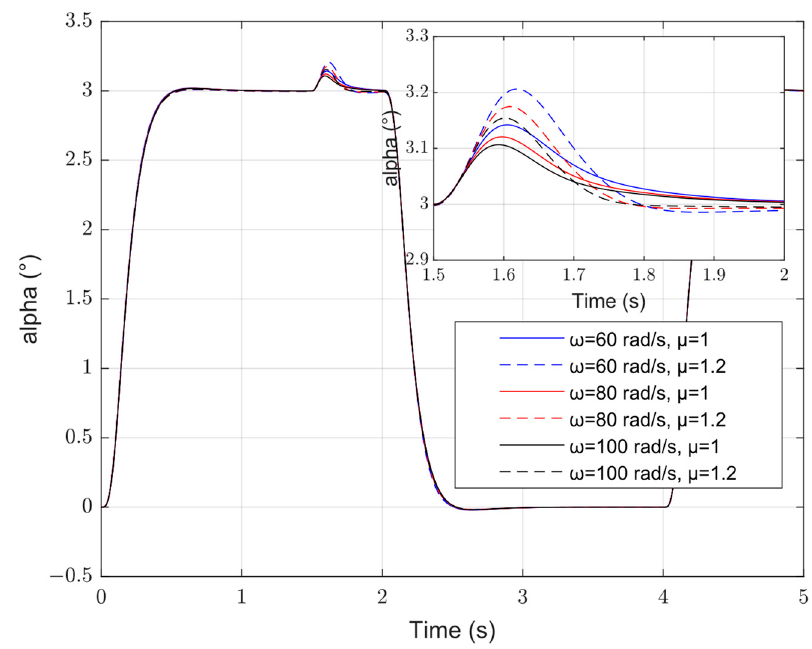
Figure 14. Response of Angle of Attack with External Disturbance.